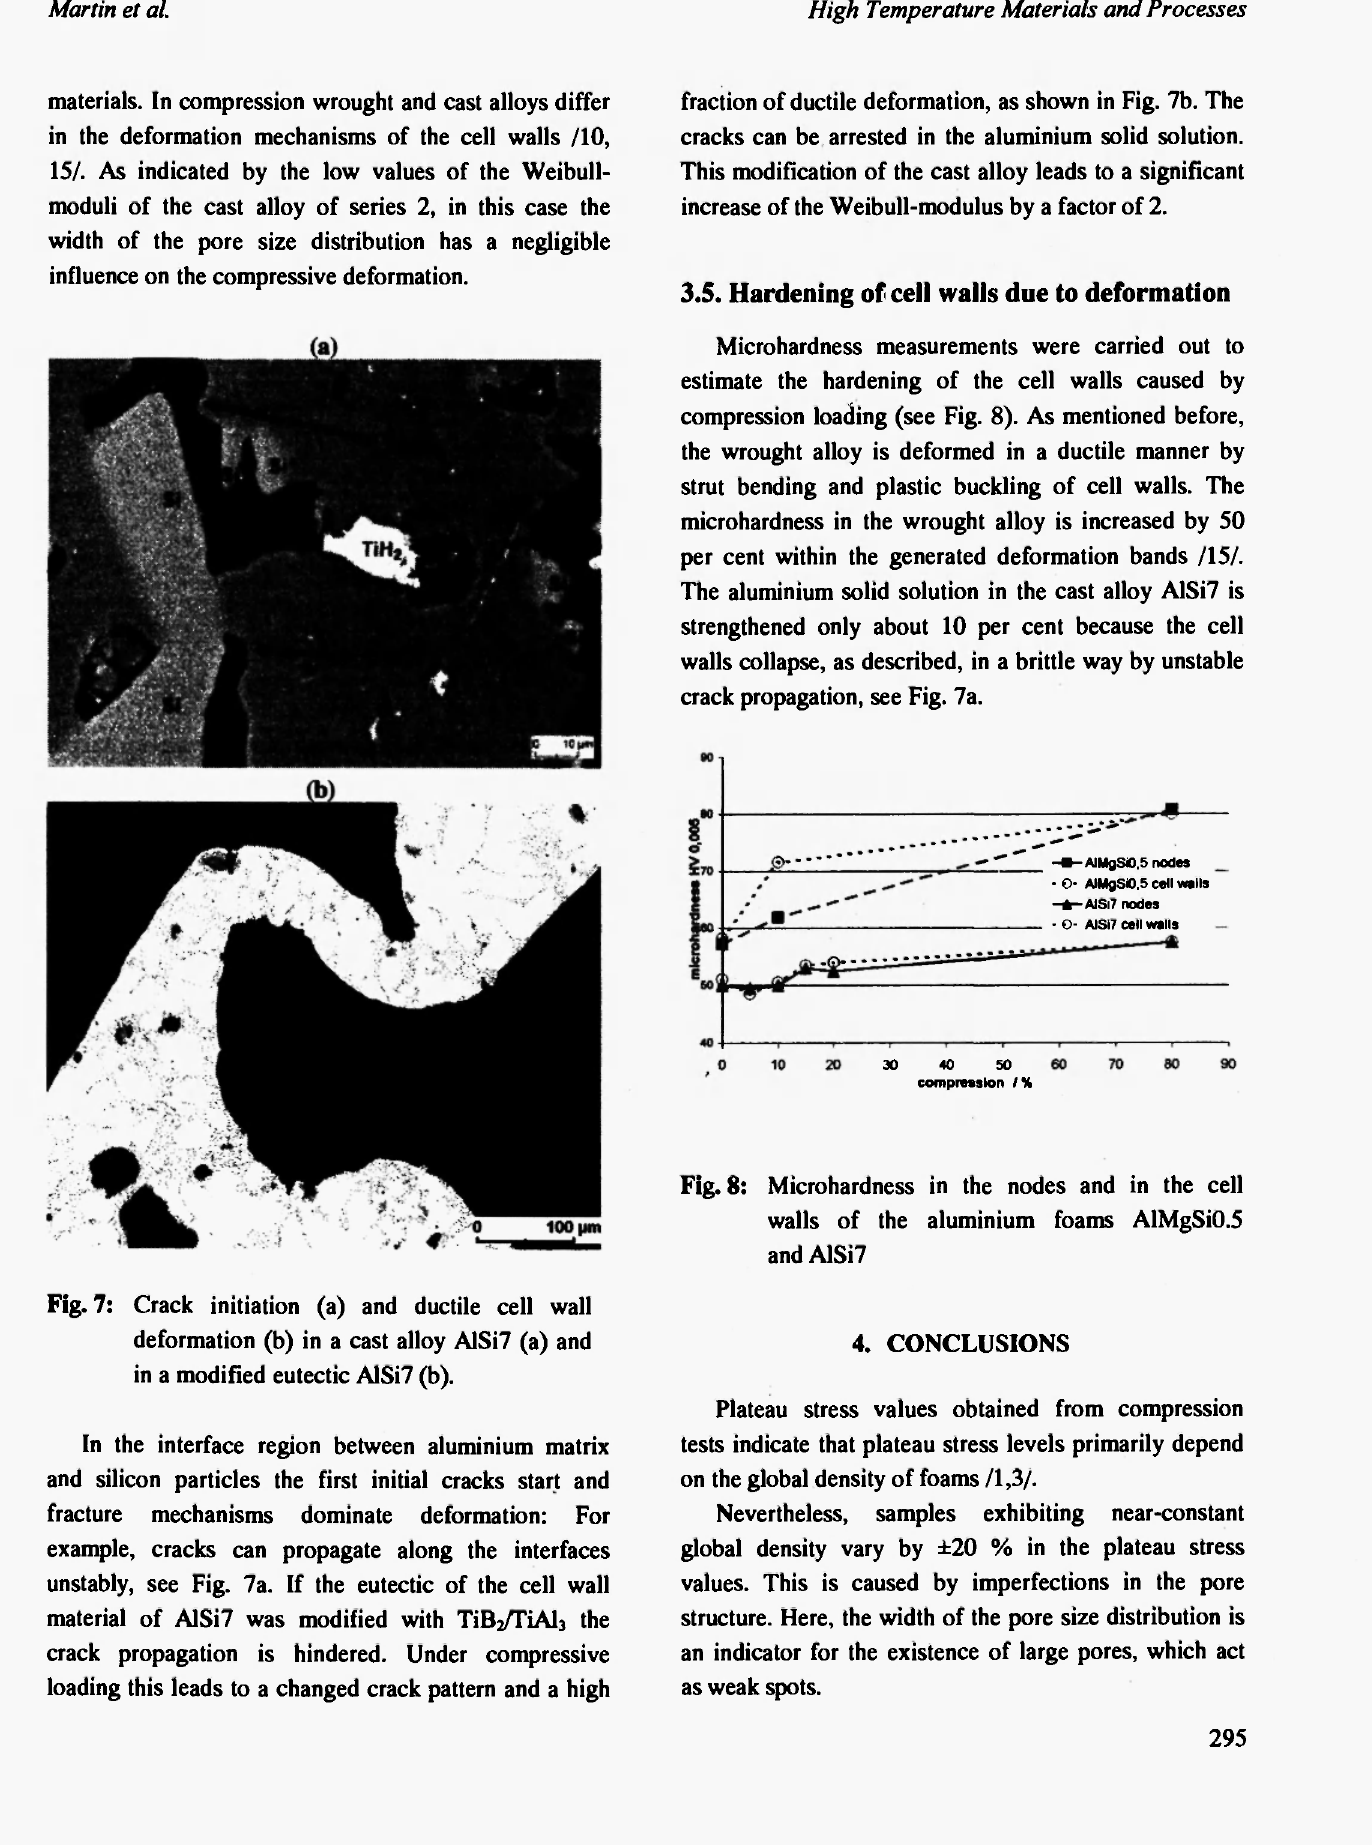
Fig. 7: Crack initiation (a) and ductile cell wall deformation (b) in a cast alloy AlSi7 (a) and in a modified eutectic AlSi7 (b).